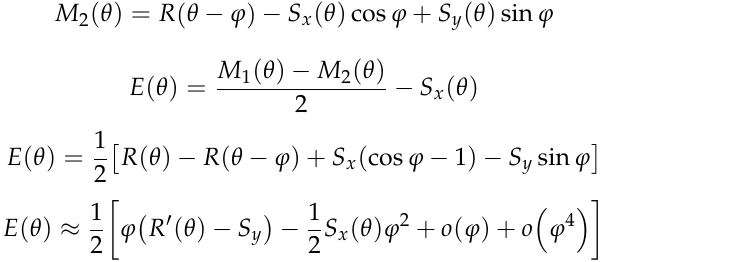
Figure 12. Positioning deviation ( a ) Standard sphere positioning deviation, ( b ) Probe positioning deviation. At the same time, the probe is required to rotate 180 ◦ relative to the spindle rotor when using the reversal method, and the probe angle position error will be introduced into the measurement signal, and the measurement schematic diagram is shown in Figure 12b. The measurement error is as follows: